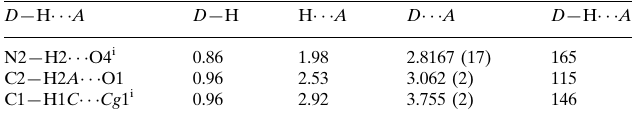
Hydrogen-bond geometry (A˚ , (cid:1) ). Cg 1 is the centroid of the C4–C9